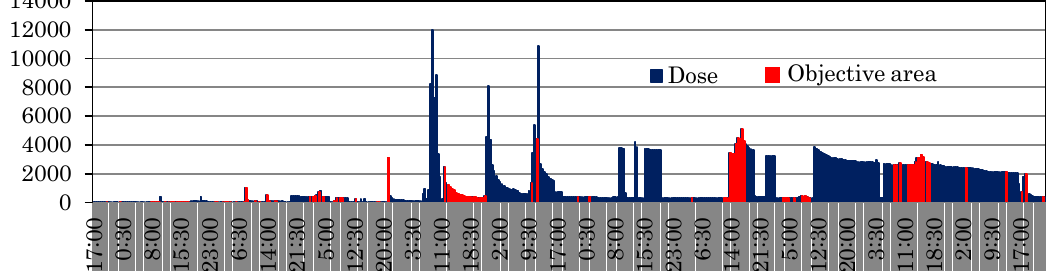
Figure 9. A time series of spatial dose (unit: μSv/h) and the ratio of pollution for Objective